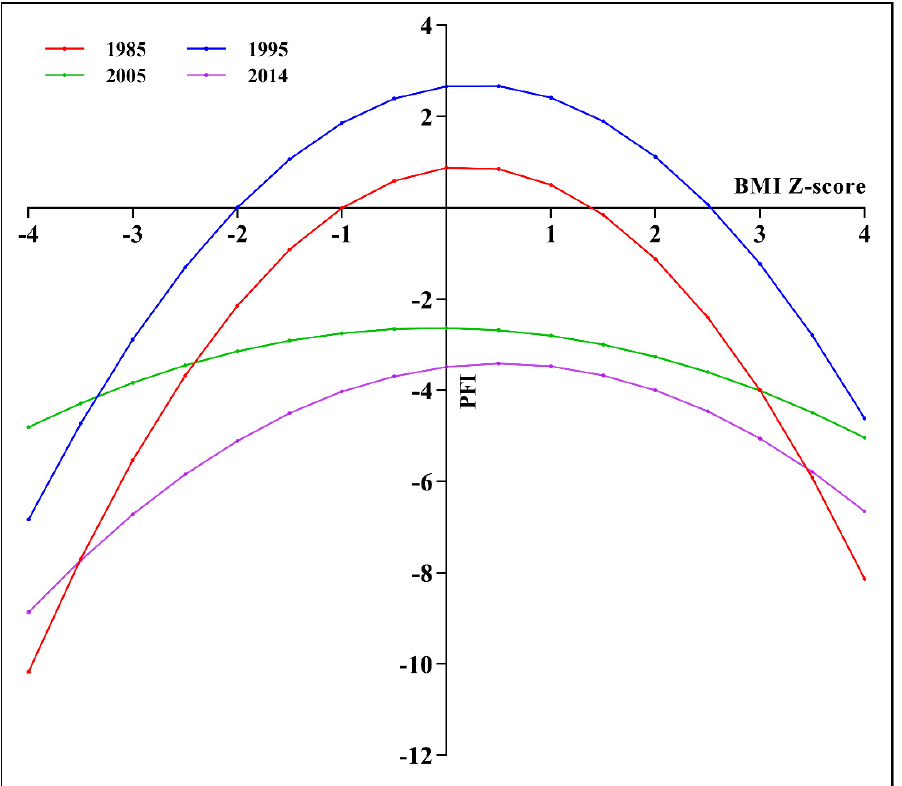
Figure 6. Relationship between body mass index (BMI) Z-score and PFI Z-score for children and adolescents in Xinjiang, 1985 to 2014.